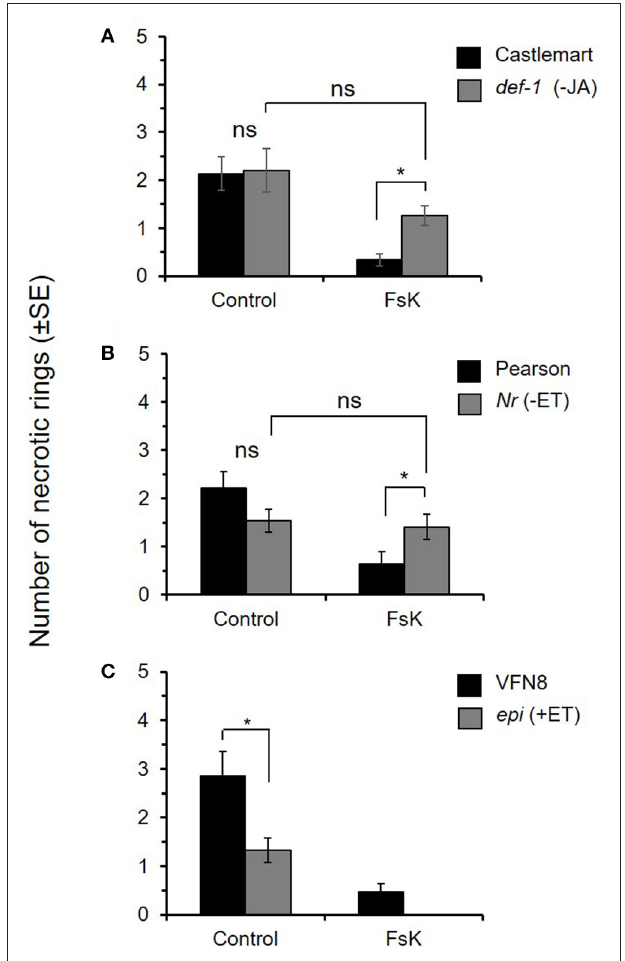
FIGURE 2 | Ethylene and jasmonate signaling is essential for the expression of Fusarium solani strain K (FsK) systemic effects on plant damage by Nesidiocoris tenuis . FsK-inoculated (FsK, N = 14–17) or non-inoculated (Control, N = 13–18) tomato plants were exposed to N. tenuis (one male, one female) for 1 week. Mean ( ± SE) total number of necrotic rings on stems and leaves on (A) Castlemart wild-type and JA-biosynthesis def-1 mutant, (B) Pearson wild-type and ethylene-insensitive Nr mutant and (C) VFN8 wild-type and ethylene overproducing epi mutant. Bars depicting numbers of necrotic rings on WT plants (except ACE55) are the same as those shown in Figure 1 . Asterisks indicate significant differences ( P < 0.05); ns, not